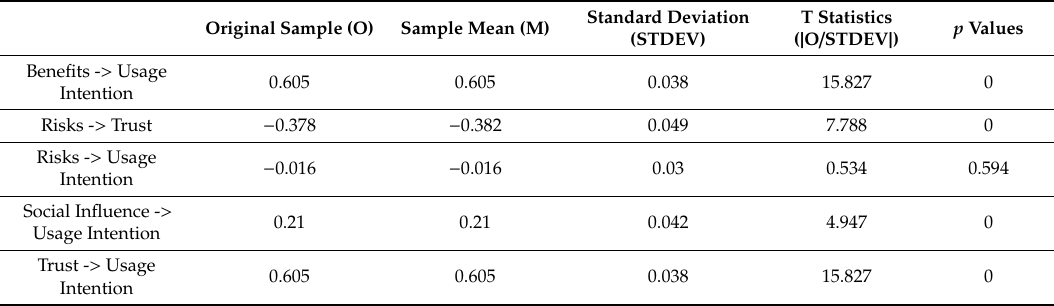
Table 7. Path coe ffi cient.